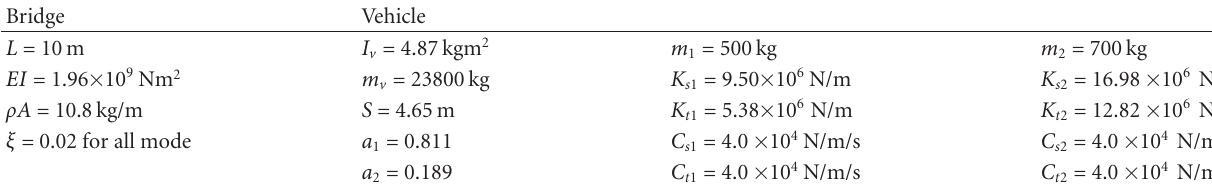
Figure 5: Actual axle loads and corresponding axle weight estimations (a) using Method I and (b) using Method II. Table 1: Parameters of vehicle and bridge WIM